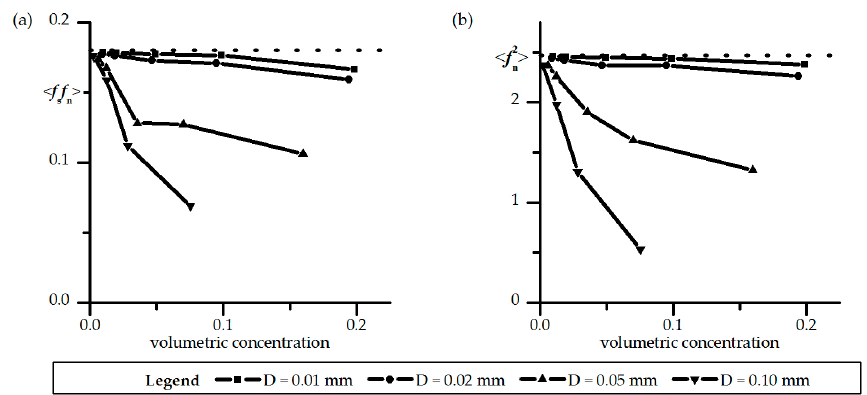
Figure 9. < f n2 > and < f s f n > variation with suspended sediment at the center of cross-section 90°. The dot line represents the clear water (CL) case. dot line represents the clear water (CL)